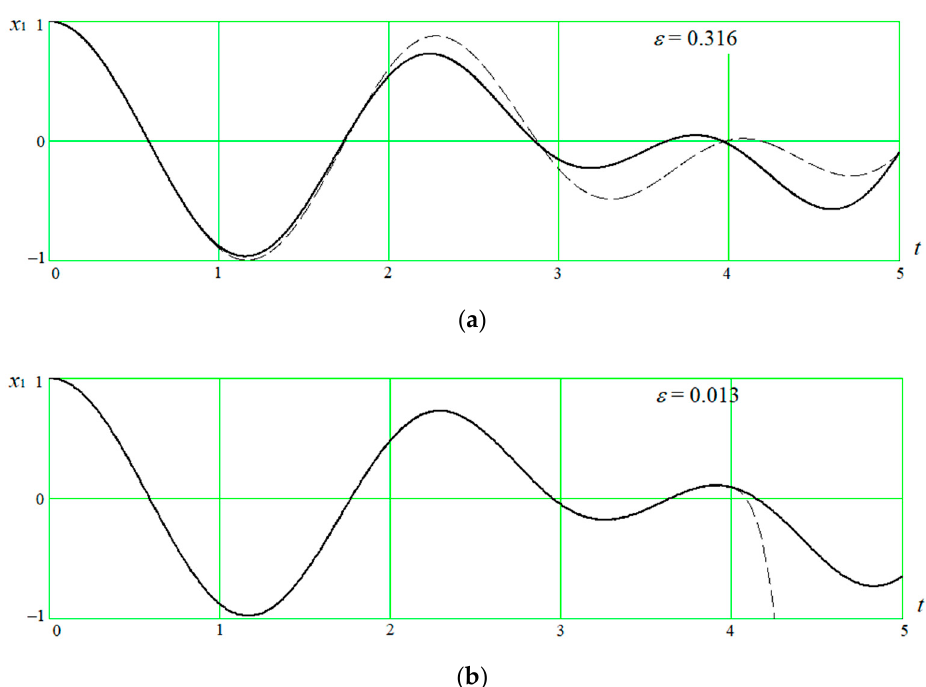
x dynamics: ( a ) piecewise approximation (dash line); ( b ) linear Figure 3. The displacement Figure 3. The displacement x 1 dynamics: ( a ) piecewise approximation (dash line); ( b ) linear stepwise approximation based 1 stepwise approximation based on the Darwin expansion (dash line is the solution based on power on the Darwin expansion (dash line is the solution based on power series).